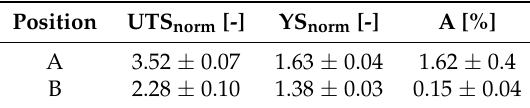
Table 3. Statistically evaluated quasi-static